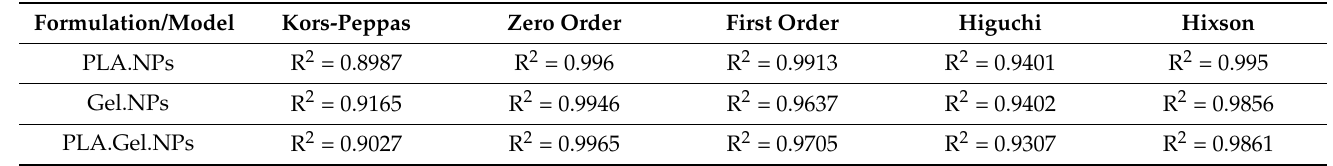
Figure 3. ( a ): Size distribution of gelatin nanofibers before coating with nanoparticles. ( b ): Size distribution of gelatin nanofibers after coating with nanoparticles. ( c ): Size distribution of PLA nanofibers before coating with nanoparticles. ( d ): Size distribution of PLA nanofibers after coating with nanoparticles. ( e ): Size distribution of gelatin/PLA nanofibers blended with nanoparticles. Table 1. R 2 values for drug release kinetic models.